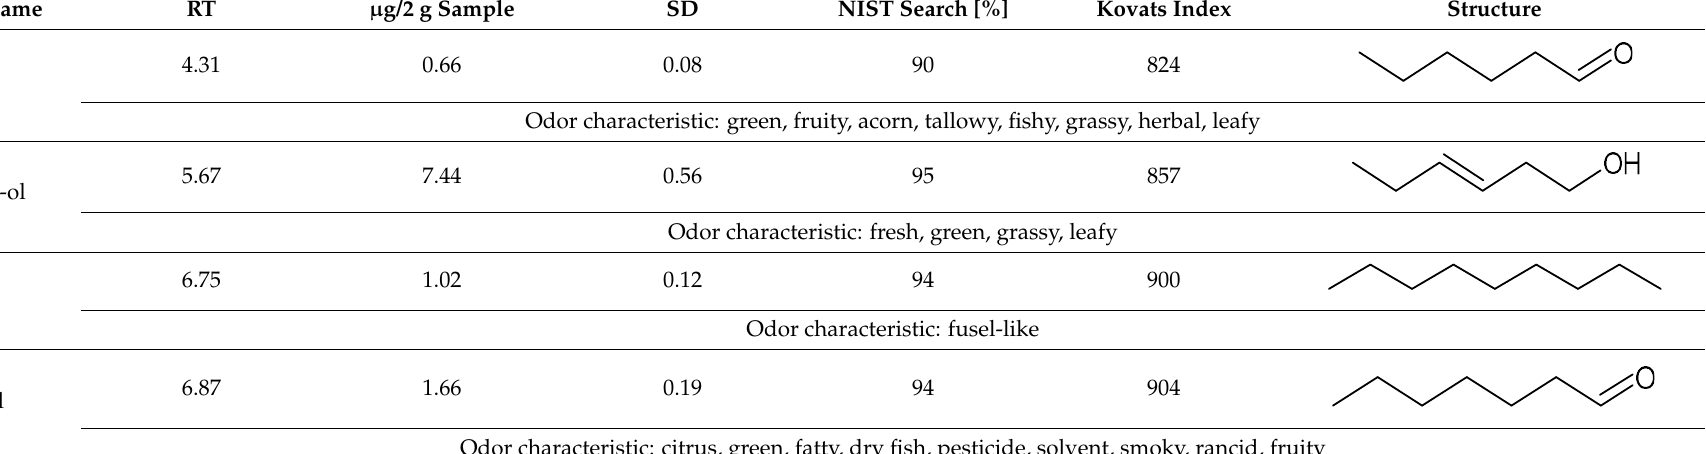
3 of 18 Figure 1. Location map of investigation area in the center of Wrocław: sampling sites: (1) 5 Kotlarska St., (2) 2–4 Jodłowa St., (3) 78–80 Szewska St., (4) Łaciarska St. (backyard), (5) 21 Kotlarska St. 2.2. HS-GC/S Analysis of Volatiles Fractions The analysis of volatiles from the sample was carried out using GC-MS QP 2010 Ultra system (Shimadzu, Kyoto, Japan) equipped with headspace autosampler HS-20 (Shi- madzu Corporation, Kyoto, Japan). A fresh sample of flowers (2 g) was weighed directly into a clean headspace vial (20 mL) with 10 mL pure water Merck Millipore (Merck Milli- pore, Warsaw, Poland) containing 180 ug 2-octanol (Sigma-Aldrich, Poznan, Poland) as